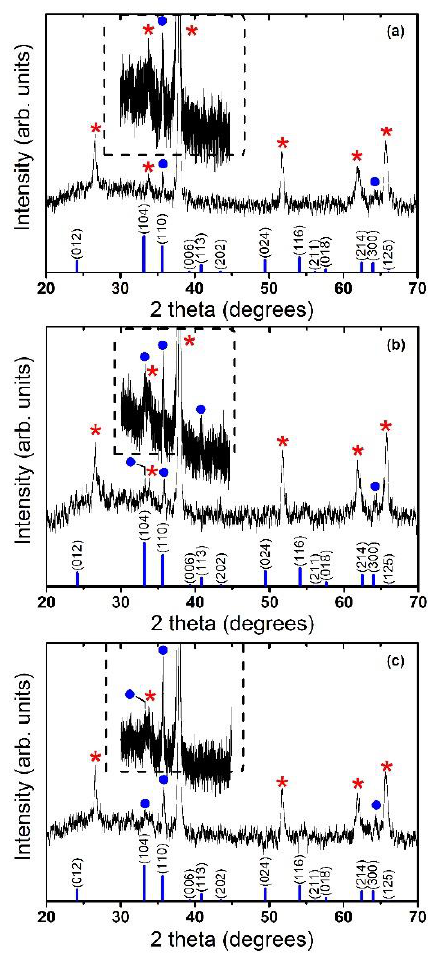
Figure 4. X-ray diffraction patterns of hematite films grown at ( a ) 14 cm, ( b ) 18 cm, and ( c ) 22 cm. JCPDS pattern of rhombohedrally centered hexagonal structure of Fe 2 O 3 ( α -Fe 2 O 3 , hematite), labeled with the corresponding crystallographic planes is also shown for comparison at the bottom of each panel. A zooming of the XRD pattern in the 2 theta range from 30 to 45 degrees is depicted as an inset in each panel. ( • ) and (*) symbols indicate the diffraction peaks originated from the hematite phase and from the SnO 2 :F substrate, respectively.